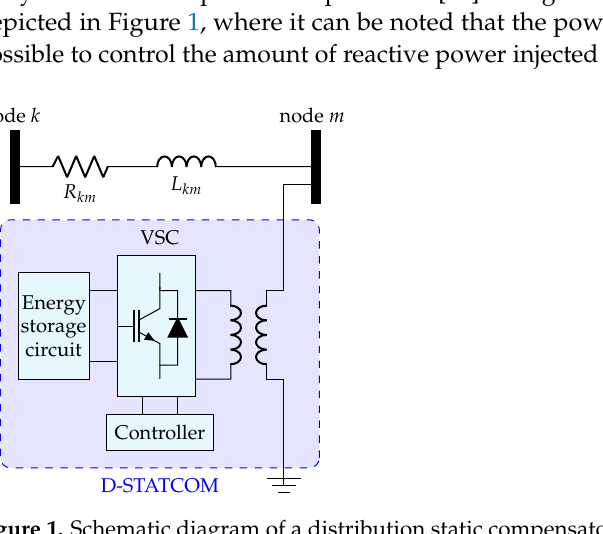
Figure 1. Schematic diagram of a distribution static compensator